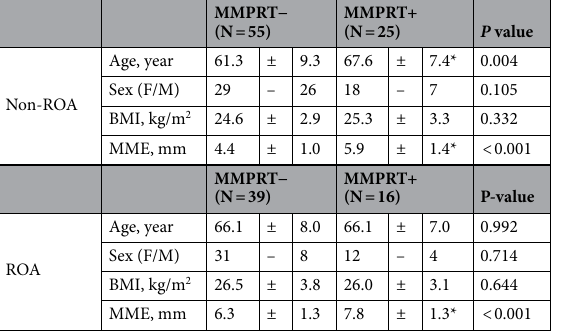
Table 1. Current participant demographic characteristics. *P ≤ 0.05, non-paired t-test; MME, medial meniscus extrusion; ROA, radiographic knee osteoarthritis (Kellgren-Lawrence grade ≥